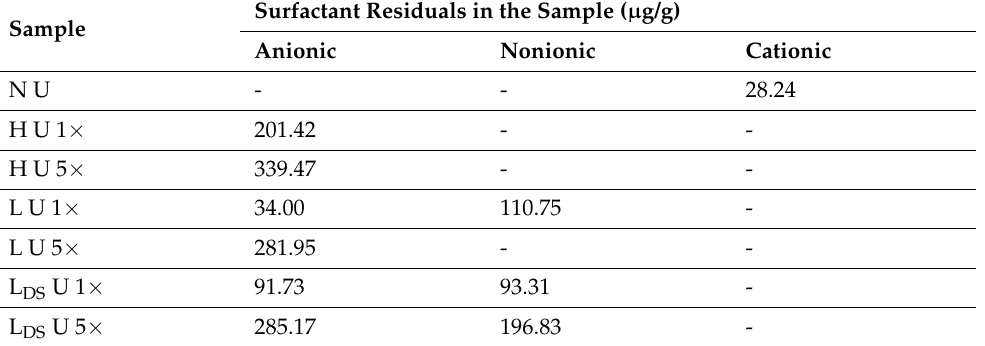
Table 11. Amounts of anionic, nonionic, and cationic surfactants in the aqueous extract of cut medical masks before and after